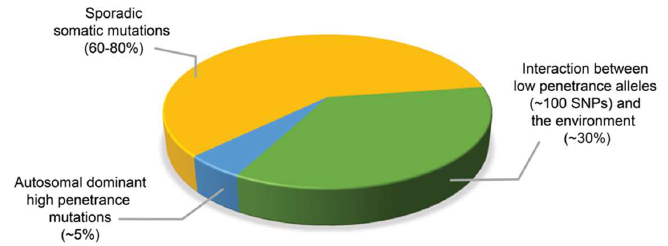
Figure 1. Approximate contribution of germline mutations, low penetrance alleles and sporadic somatic mutations to prostate cancer incidence. While most prostate cancer arise from sporadic somatic mutations, about 5% of prostate cancers develop from autosomal dominant highly penetrant germline mutations, and approximately 30% of cases of prostate cancer occur as a result of interaction between genes with low penetrance alleles and the environment.